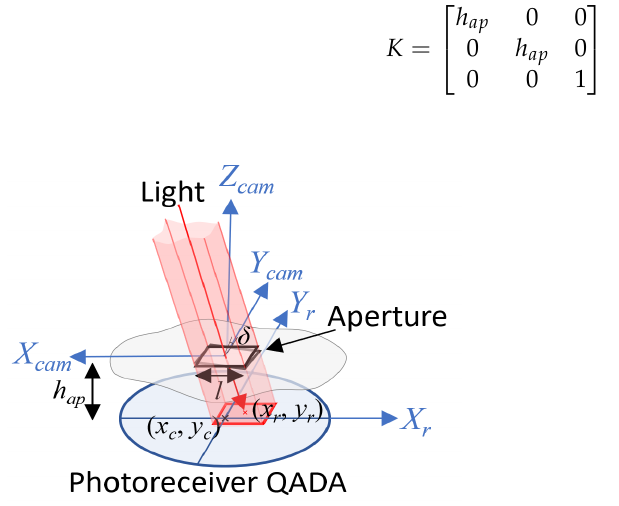
Figure 2. Representation of the geometry of the QADA sensor and the aperture over it. Once the image points for each transmitter i are obtained, different PnP solutions can be directly applied to estimate the pose of the receiver in the proposed scenario. The